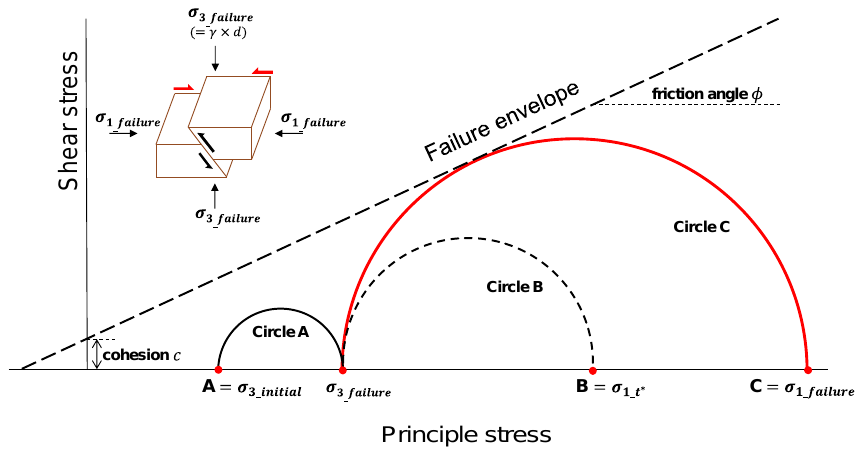
Figure 4. Schematic diagram illustrating the Mohr–Coulomb failure criterion; circle A represents the initial state after a thrust-fault earth- quake or at t 0 , circle B denotes stress states at t ∗ after t 0 , and circle C is the stress state corresponding to the failure state that causes rock failure and earthquakes.